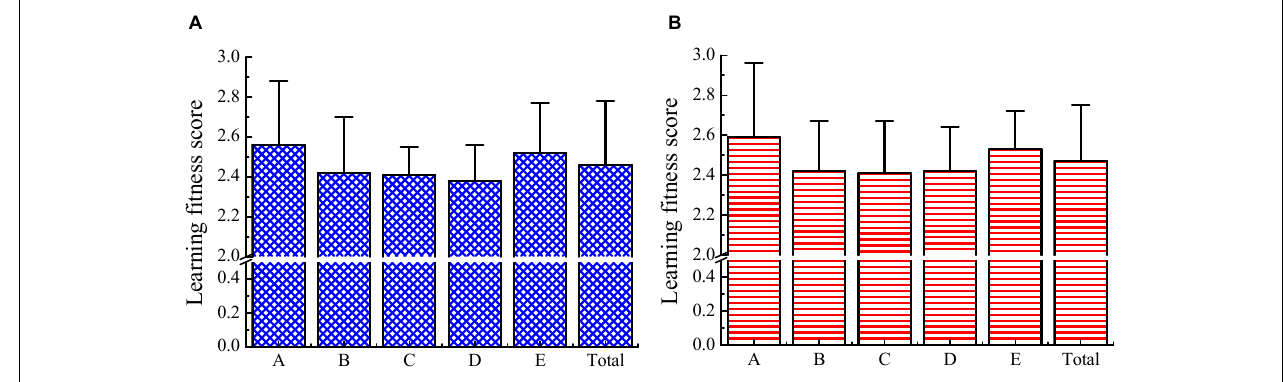
FIGURE 12 | Comparison in children’s learning adaptability scores. (A) The scores of migrant children; (B) the score of local children; A refers to learning attitude; B refers to listening method; C refers to learning skills; D indicates the adaptability to the school teaching environment; and E represents the independent learning